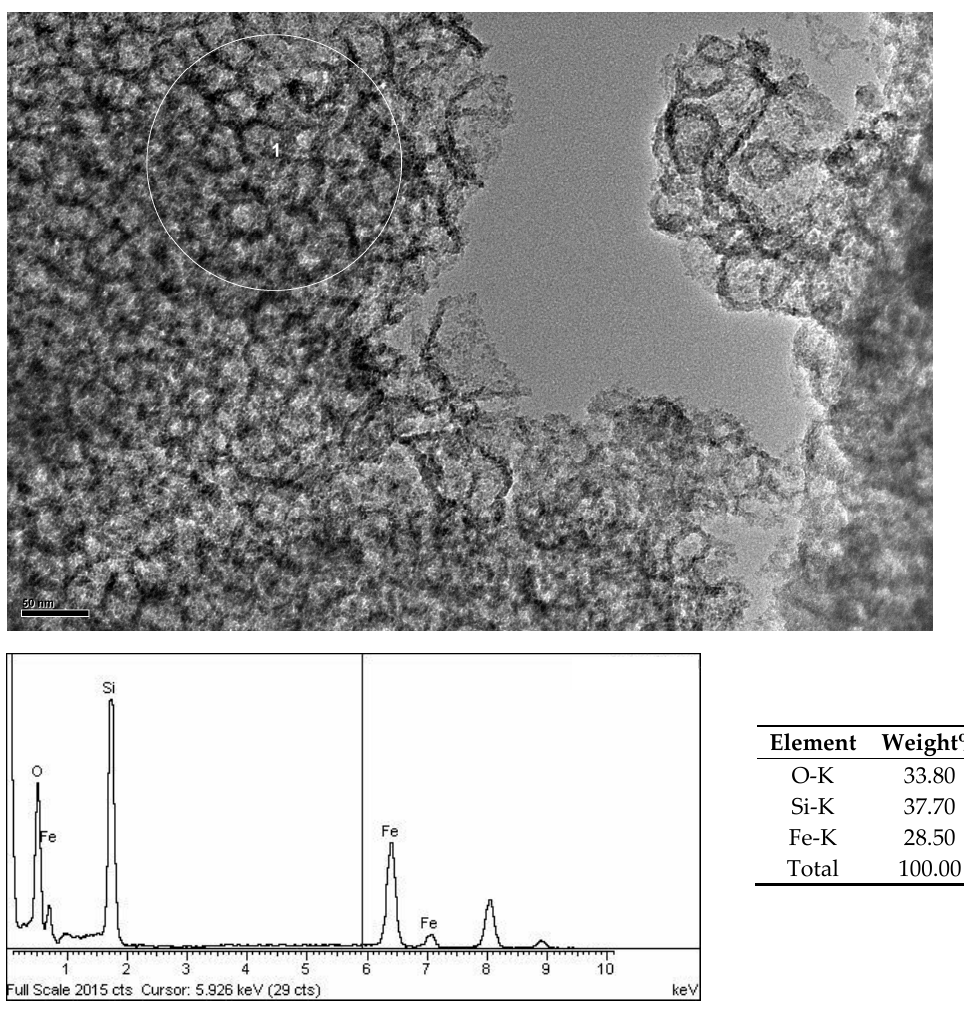
Figure 8. TEM image and TEM-EDS (transmission electron microscopy-energy dispersive spectroscopy) spectrum of Pd/Fe nanoparticles supported on mesoporous silica that have reacted with trichloroethylene for 34 h. The weight percentage of Pd to Fe is 0.075%, C TCE,0 = 23.7 mg/L (0.181 mmol/L),